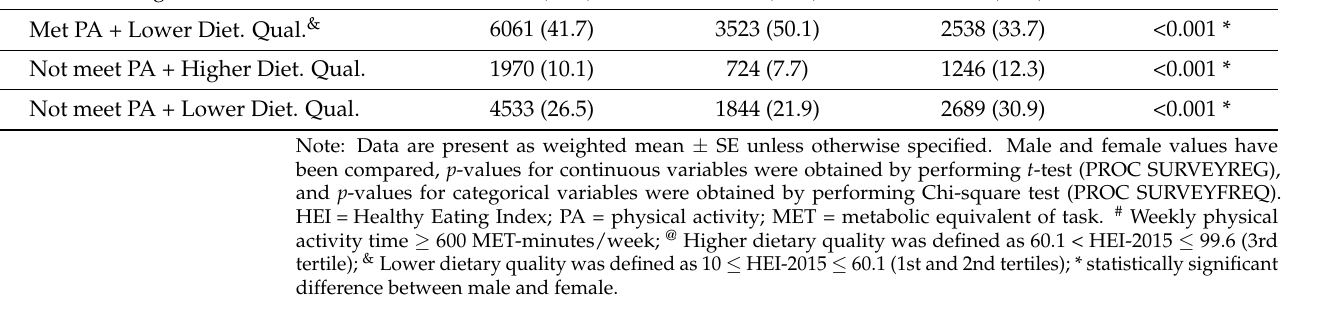
Table 2. The prevalence of diabetes according to the four lifestyle groups ( n =